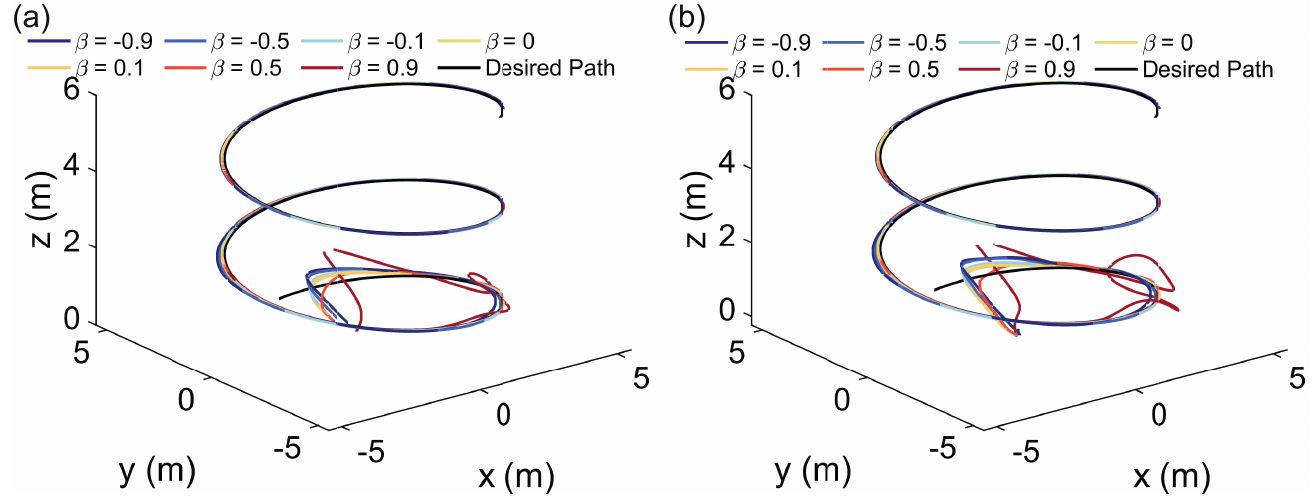
Figure 5. Simulated results that demonstrate the robustness of the varying fractional orders in the proposed controller to various input delays: ( a ) τ = 0.05 s, ( b ) τ = 0.1 s. (Assume that τ = τ 1 = τ 2 = τ 3 = τ 4 and no payload is applied.) Table 8. Root mean squared error (RMSE) of the simulated tracks under different input time delays and different fractional orders in the proposed controller.